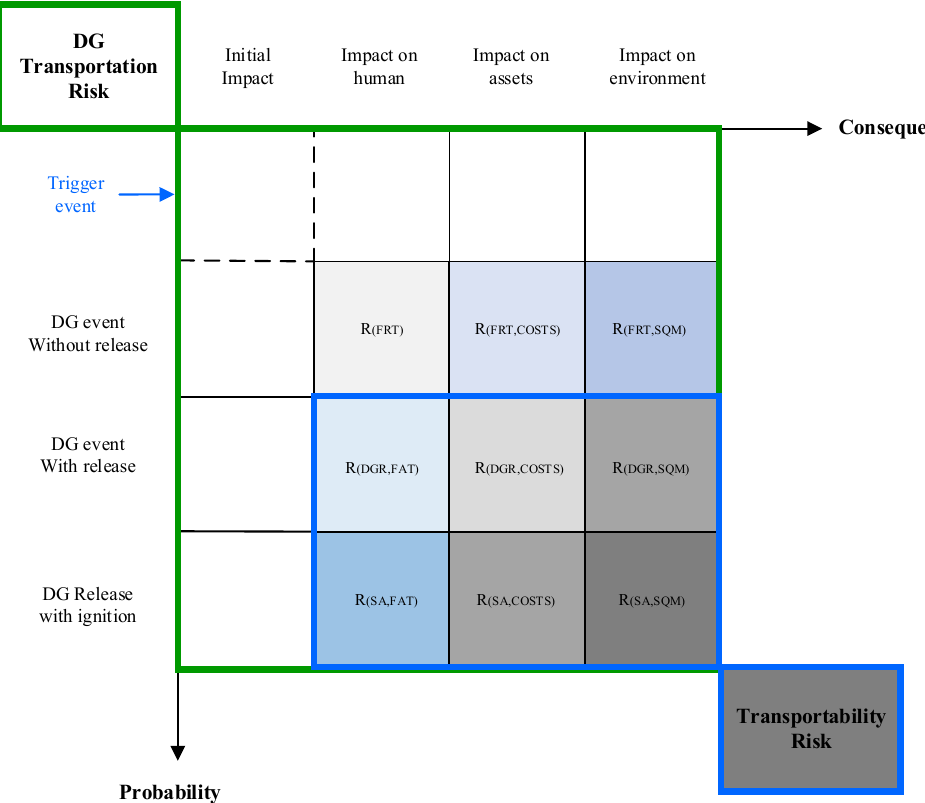
Figure 1. Conceptual diagram of waterway transportability evaluation of dangerous goods.